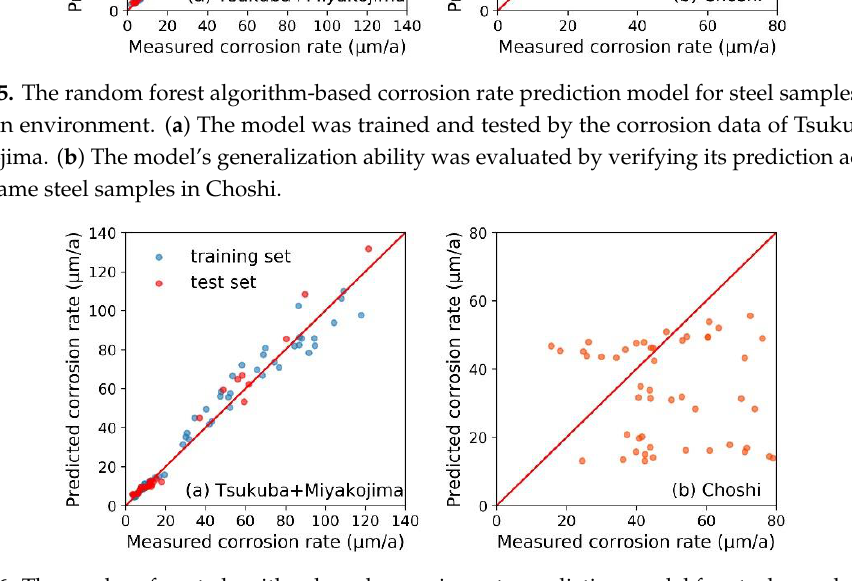
Figure 6. The random forest algorithm-based corrosion rate prediction model for steel samples under the sheltered environment. ( a ) The model was trained and verified by the corrosion data of Tsukuba and Miyakojima. ( b ) The model’s generalization ability was evaluated by verifying its prediction accuracy to the same steel samples in Choshi.